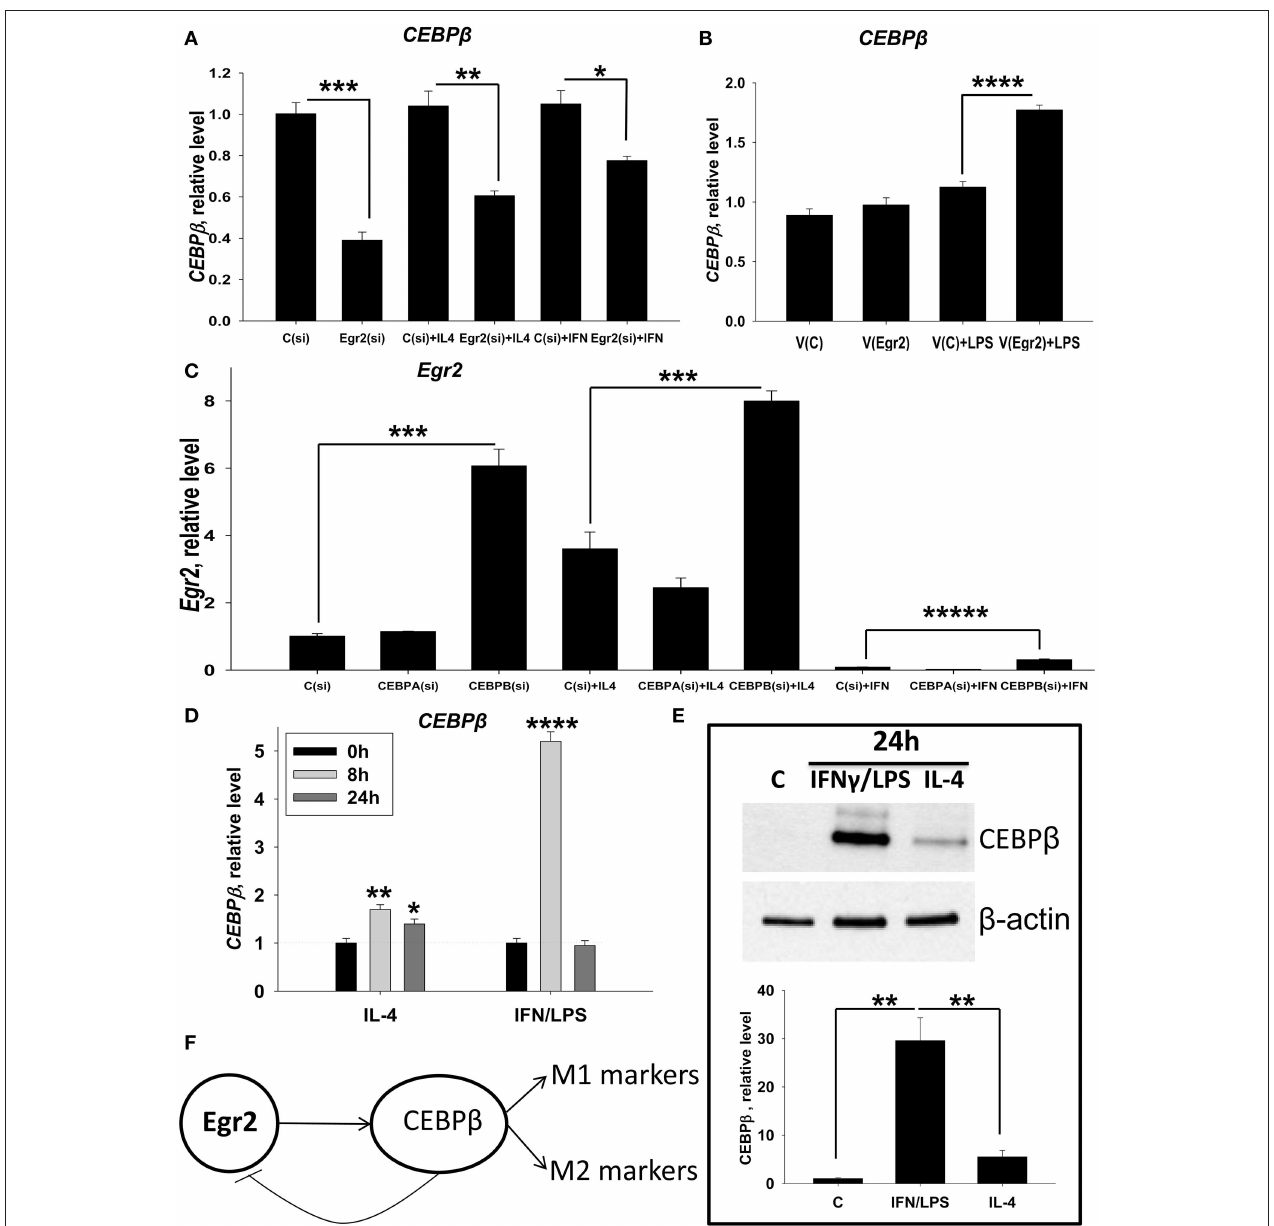
FIGURE 12 | Analysis of reciprocal regulation of CEBP β and Egr2 in M1 and M2 macrophages. (A) Effect of inhibition of Egr2 on CEBP β expression in M0, M2, and M1 macrophages. Bone-marrow-derived macrophages (BMDMs) were transfected with siRNA cocktail for Egr2 [Egr2(si)] or control siRNA [C(si)] for 24h as described in Materials and Methods , and after which the cells were used as unstimulated [C(si) and Egr2(si)] or activated with IL-4 [C(si) + IL4 and Egr2(si) + IL4] or IFN γ [C(si) + IFN and Egr2(si) + IFN] for another 24 h-time period as in Figure 3 . The cells were washed, mRNA was isolated and the expressions of CEBP β was analyzed by real-time PCR as described in Materials and Methods . (B) Effect of overexpression of Egr2 on CEBP β expression in M1 macrophages. Macrophage cell line RAW264.7 was transfected with pMIG expression vector plasmid or empty plasmid vector [V(C) or vector with Egr2 (V(Egr2)] for 24h and after which the cells were used as unstimulated [V(C) and V(Egr2)] or activated with LPS for another 24 h-time period [V(C) + LPS and V(Egr2) + LPS] as in Figure 8 . The cells were washed, mRNA was isolated and the expressions of CEBP β were analyzed by real-time PCR as described in Materials and Methods. (C) Effect of inhibition of CEBP β on Egr2 expression in unstimulated (M0), M2, and M1 macrophages. BMDMs were transfected with siRNA cocktail for CEBP α [CEBPA(si)], CEBP β [CEBPB(si)], or control siRNA [C(si)] for 24h as described in Materials and Methods . After which, the cells were used as unstimulated [C(si), CEBPA(si), and CEBPB(si)] or activated with IL-4 [C(si) + IL4, CEBPA(si) + IL4, and CEBPB(si) + IL4] or IFN γ [C(si) + IFN, CEBPA(si) + IFN and CEBPB(si) + IFN] for another 24 h-time period as in Figure 3 . The cells were washed, mRNA was isolated and the expressions of Egr2 was analyzed by real-time PCR as described in Materials and Methods . (D) Kinetics of expression